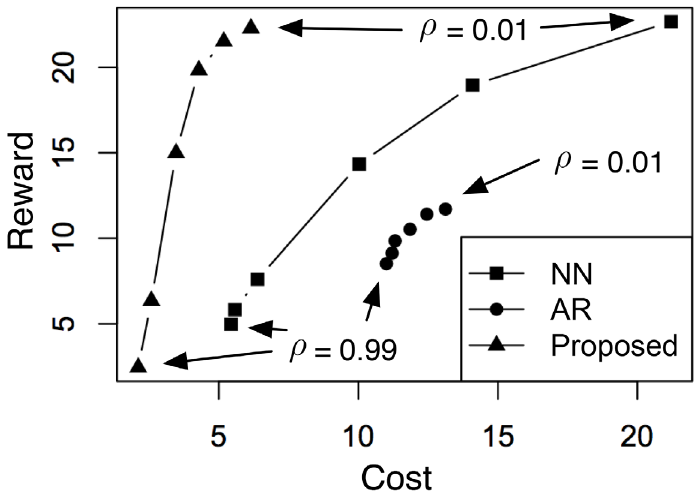
Fig 7. Tradeoff between cost and mismatch using different values of ρ . For each method, the point in the upper-right corner corresponds to the case of ρ = 0.01, whereas the point in the lower-left corresponds to the case of ρ =